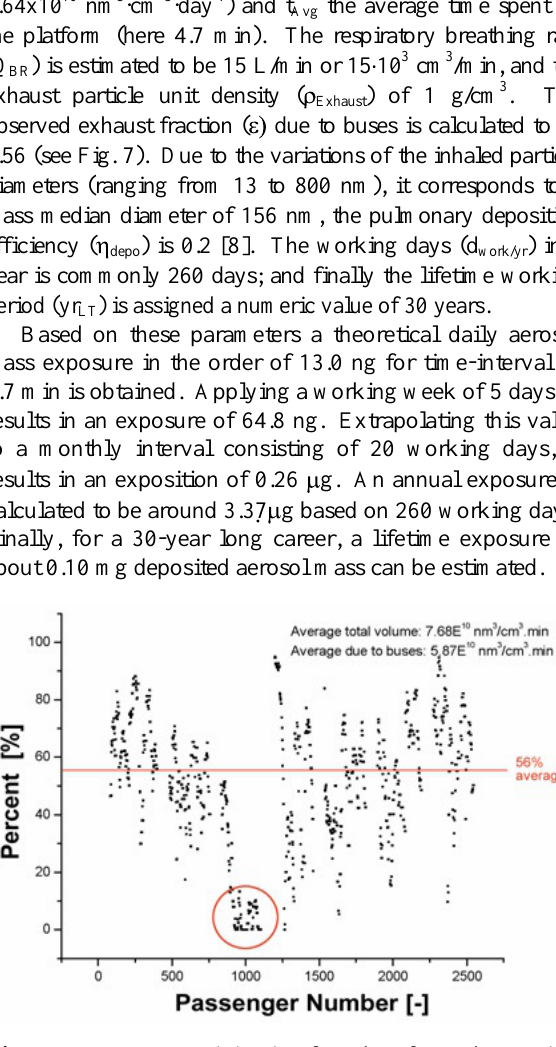
Figure 7: Exposure originating from bus fumes by particle volume concentration [nm 3 /cm 3 min], which corresponds to mass (see text). The circled area indicates the flushing effect when longitudinal winds blow through the Busway Canyon (red